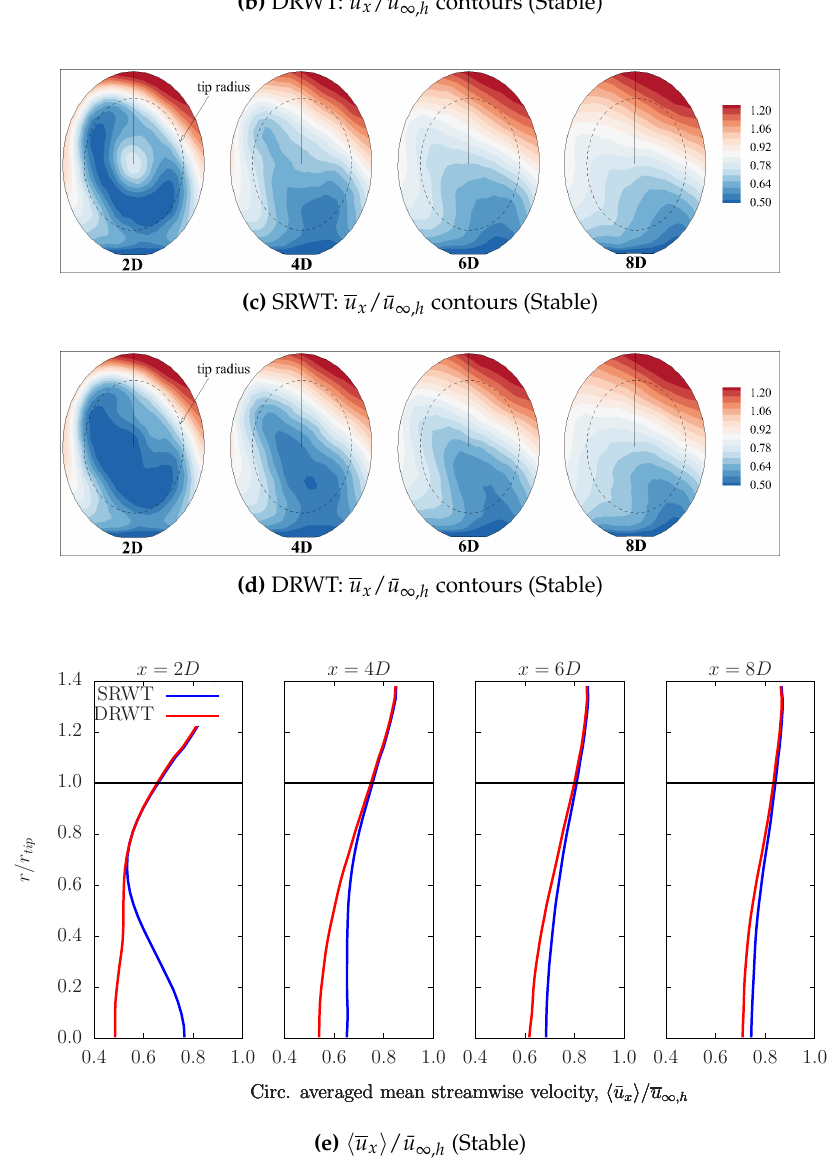
Figure 9. Comparison between SRWT and DRWT of the normalized mean streamwise velocity, u x / u ∞ , h : ( a , b ) on the x - z plane passing through the rotor hub; ( c , d ) on cross-stream ( y - z ) planes; and ( e ) circumferentially averaged values at four downstream locations ( x / D = 2, 4, 6, and 8) for the stable ABL